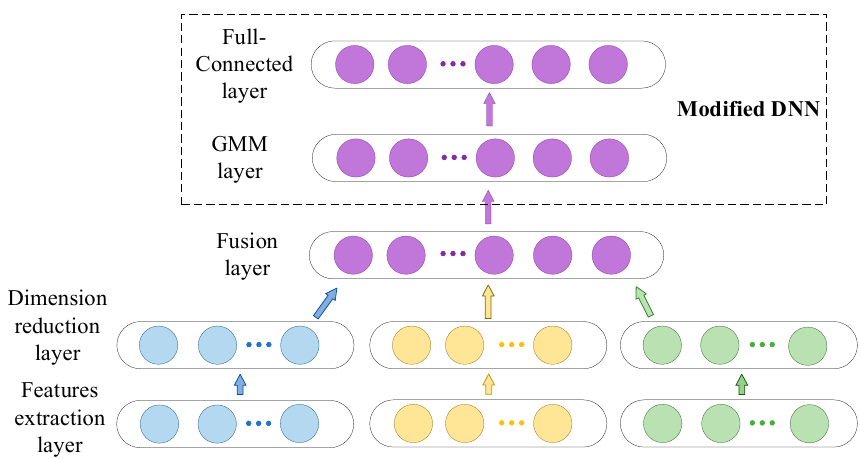
Figure 10. Schematic diagram of the modified deep neural network (DNN).